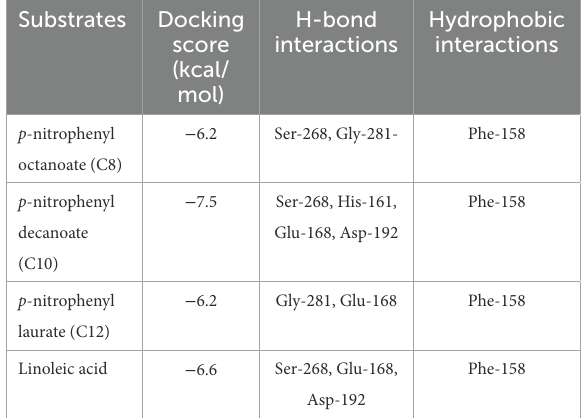
TABLE 4 The molecular docking results of Lip54q with several long C-chain substrates. Substrates Docking H-bond score (kcal/ mol)